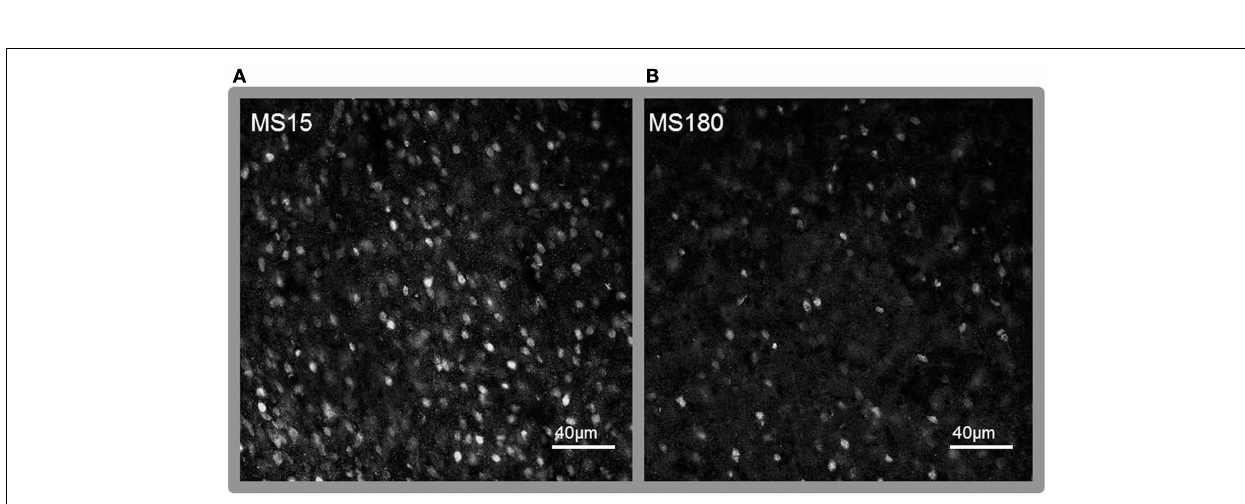
FIGURE 7 | Representative photomicrographs of immunolabeling for MeCP2 in the NAc core . (A) MS15, (B) MS180. Scale bar represents 40 µ